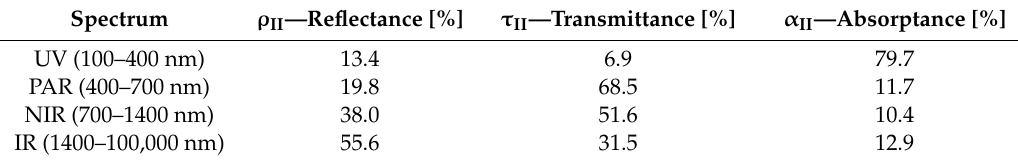
Table 2. Optical properties of OPV structure II.